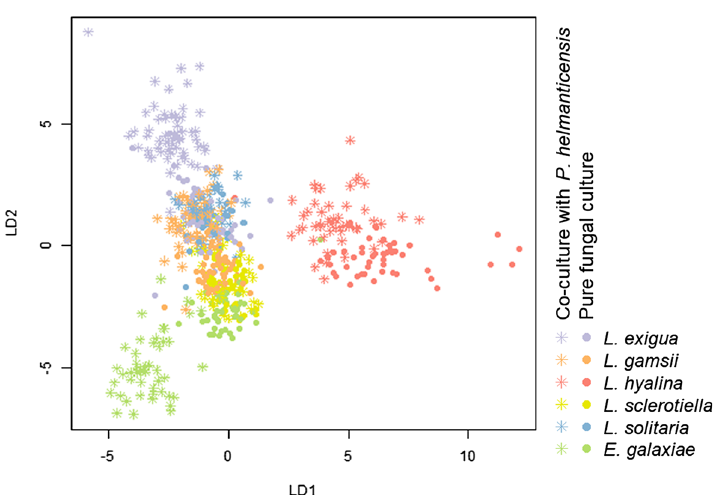
Figure 5. Linear discriminant analysis predictions based on the volatilomes of Linnemannia and Entomortierella species in fungal pure culture and co-cultivated with Pseudomonas helmanticensis . The cultivation mode and taxonomic affiliation to species was predicted. The prediction accuracy was calculated as the number of correctly assigned samples relative to the total size of the test dataset. The accuracy was high: 94% (144/154